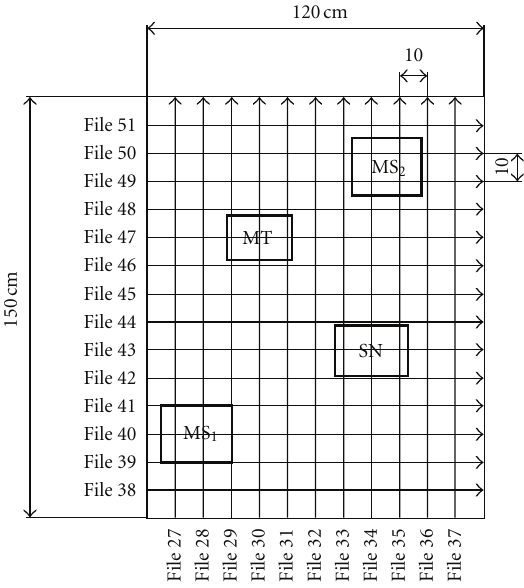
Figure 2: Plant of the box: the axes are in cm, the first metallic sheet (MS 1 ) is at the depth of 50cm, the box filled up with magnetite (MT), and the box filled up with sand (SN) is at the depth of 41.5 cm (meant with respect to their top); the second metallic sheet (MS 2 ) is at the depth of 80 cm.